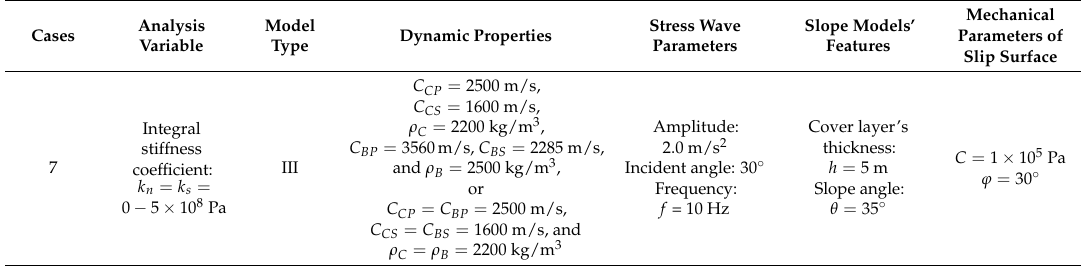
Table 4. The variables and parameters for effect analysis of deformation stiffness of discontinuous surface (P-, and SV-waves).